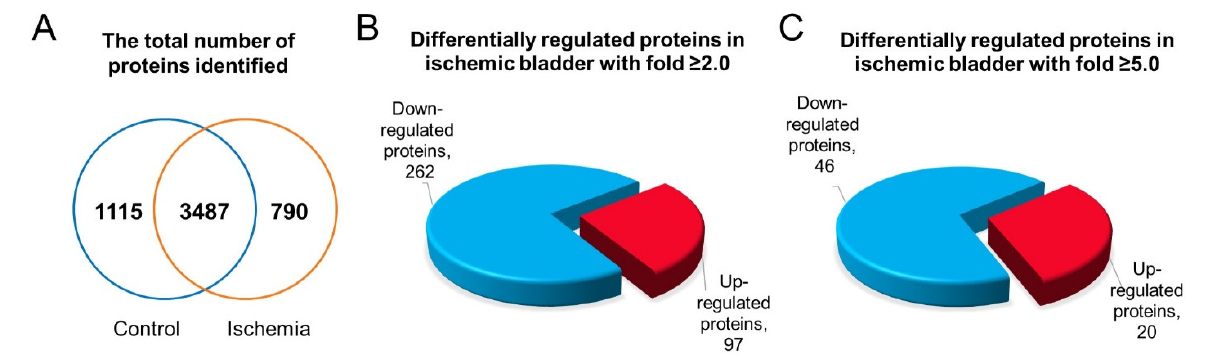
Figure 8. ( A ) Total number of proteins that are identified in the ischemic and control bladder tissue lysates. ( B ) Upregulated ( ≥ 2.0-fold) and downregulated ( ≥ 2.0-fold) proteins in the ischemic bladder. ( C ) Upregulated ( ≥ 5.0-fold) and downregulated ( ≥ 5.0-fold) proteins in the ischemic bladder. This figure is taken from our previous publication [48].